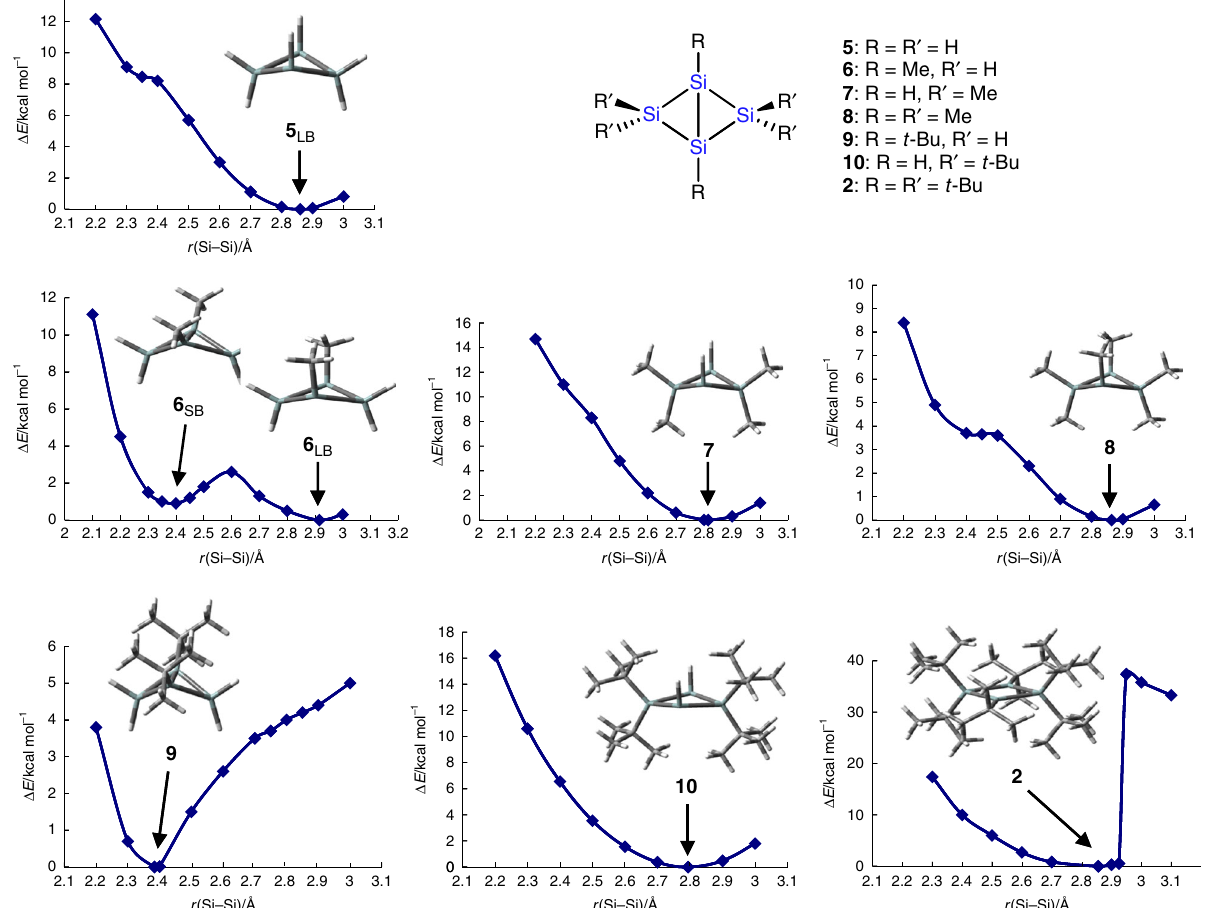
Fig. 3 Energy curves of 2 and 5 – 10 calculated at the B3LYP/6-31G(d) level. The terms SB and LB denote short-bond and long-bond isomers,